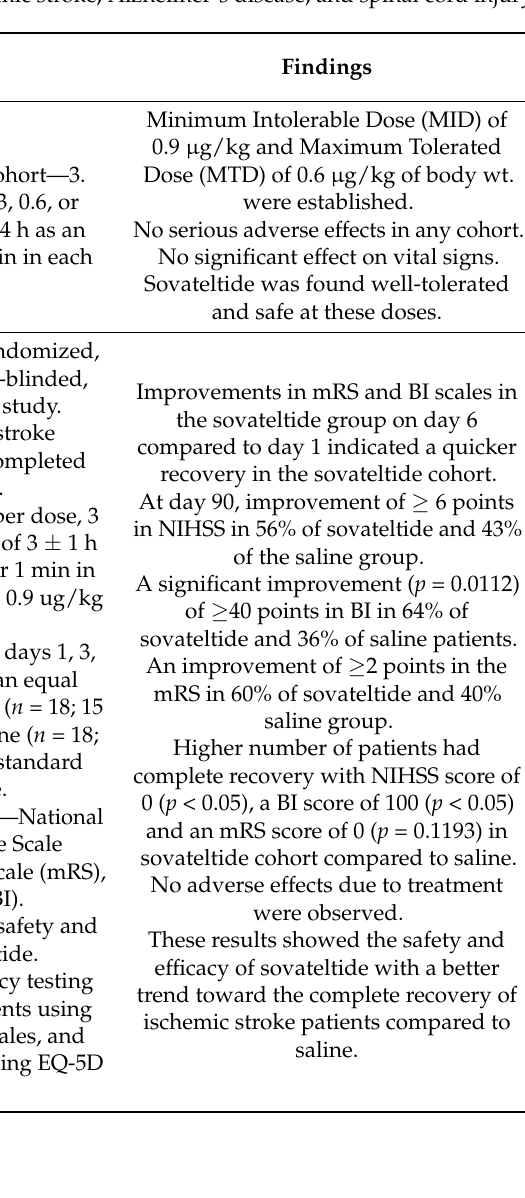
Table 1. Clinical trials of sovateltide for ischemic stroke, Alzheimer’s disease, and spinal cord